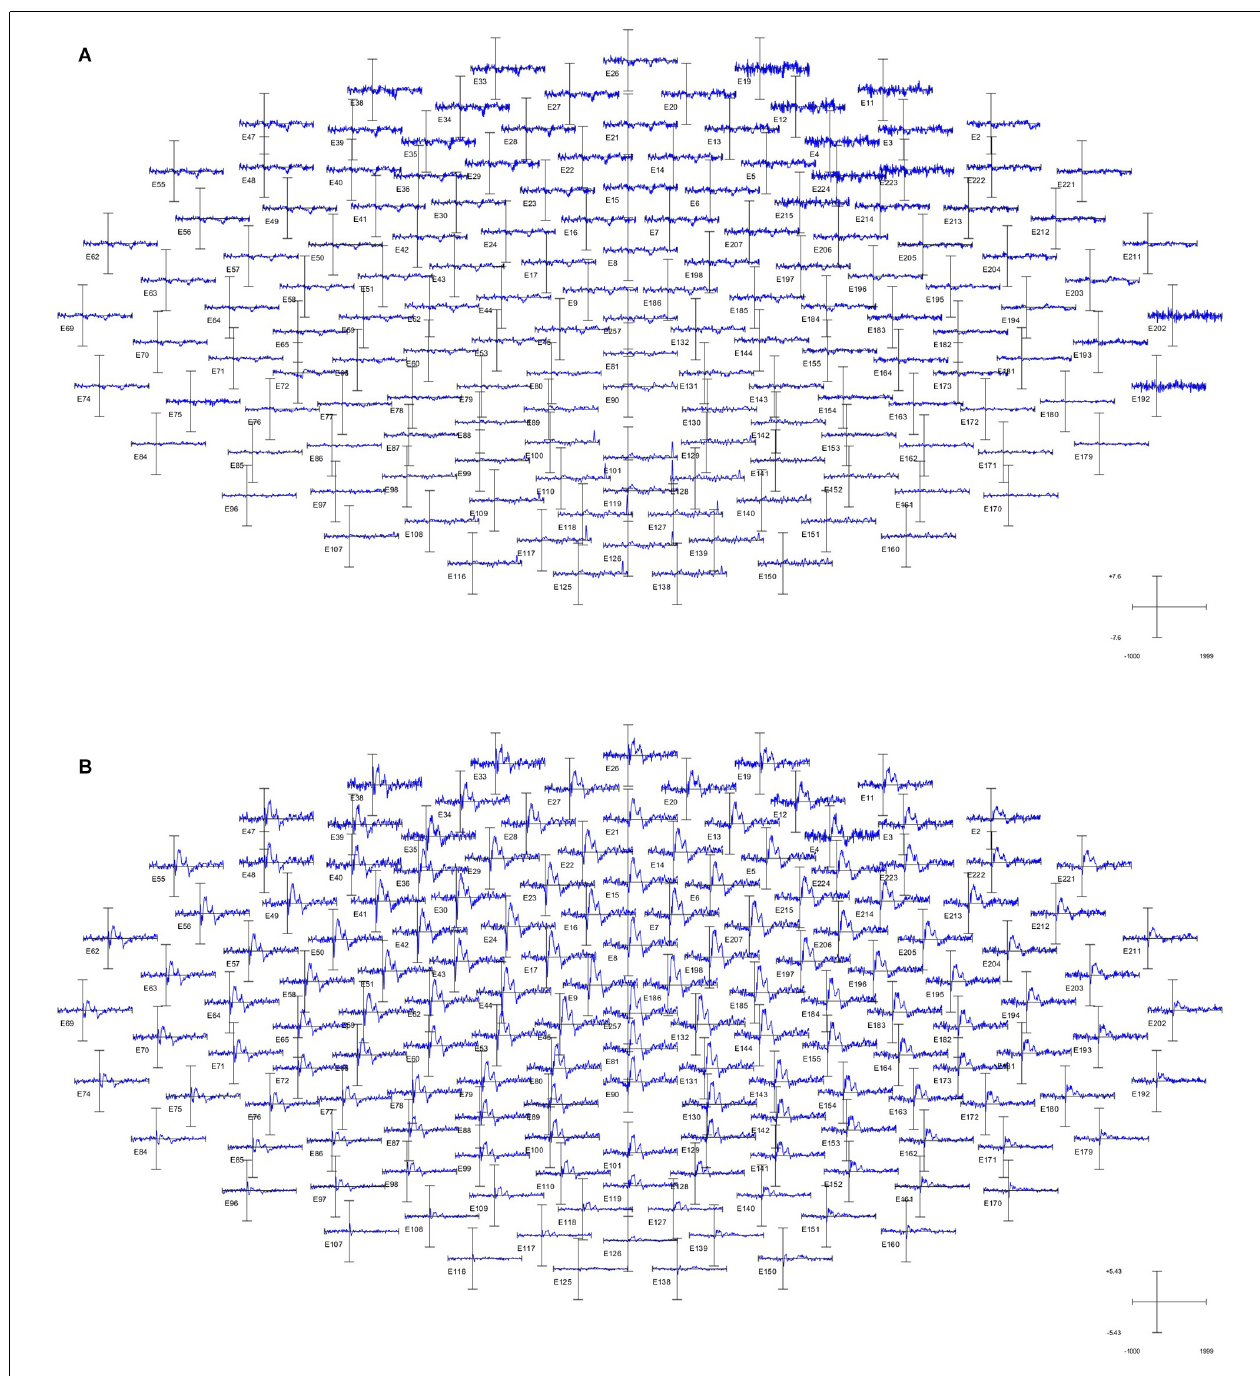
FIGURE 3 | Time-domain diagram of the whole brain of subject 1. (A) Non-projected finger map (NPFM) was stimulated. (B) PFM was stimulated.